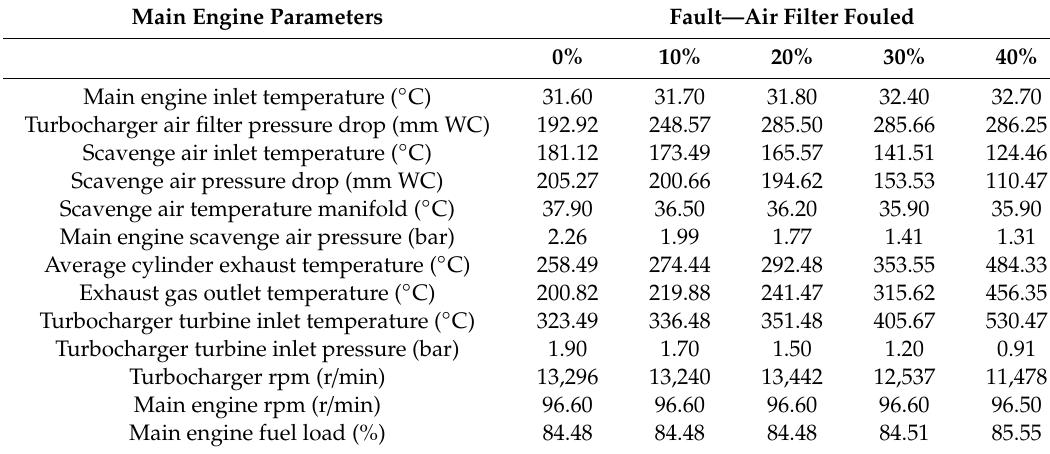
Table 1. Air filter